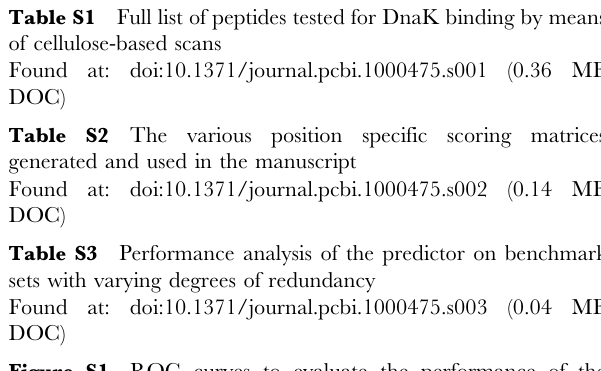
Figure S1 ROC curves to evaluate the performance of the algorithm on benchmark sets with varying degree of